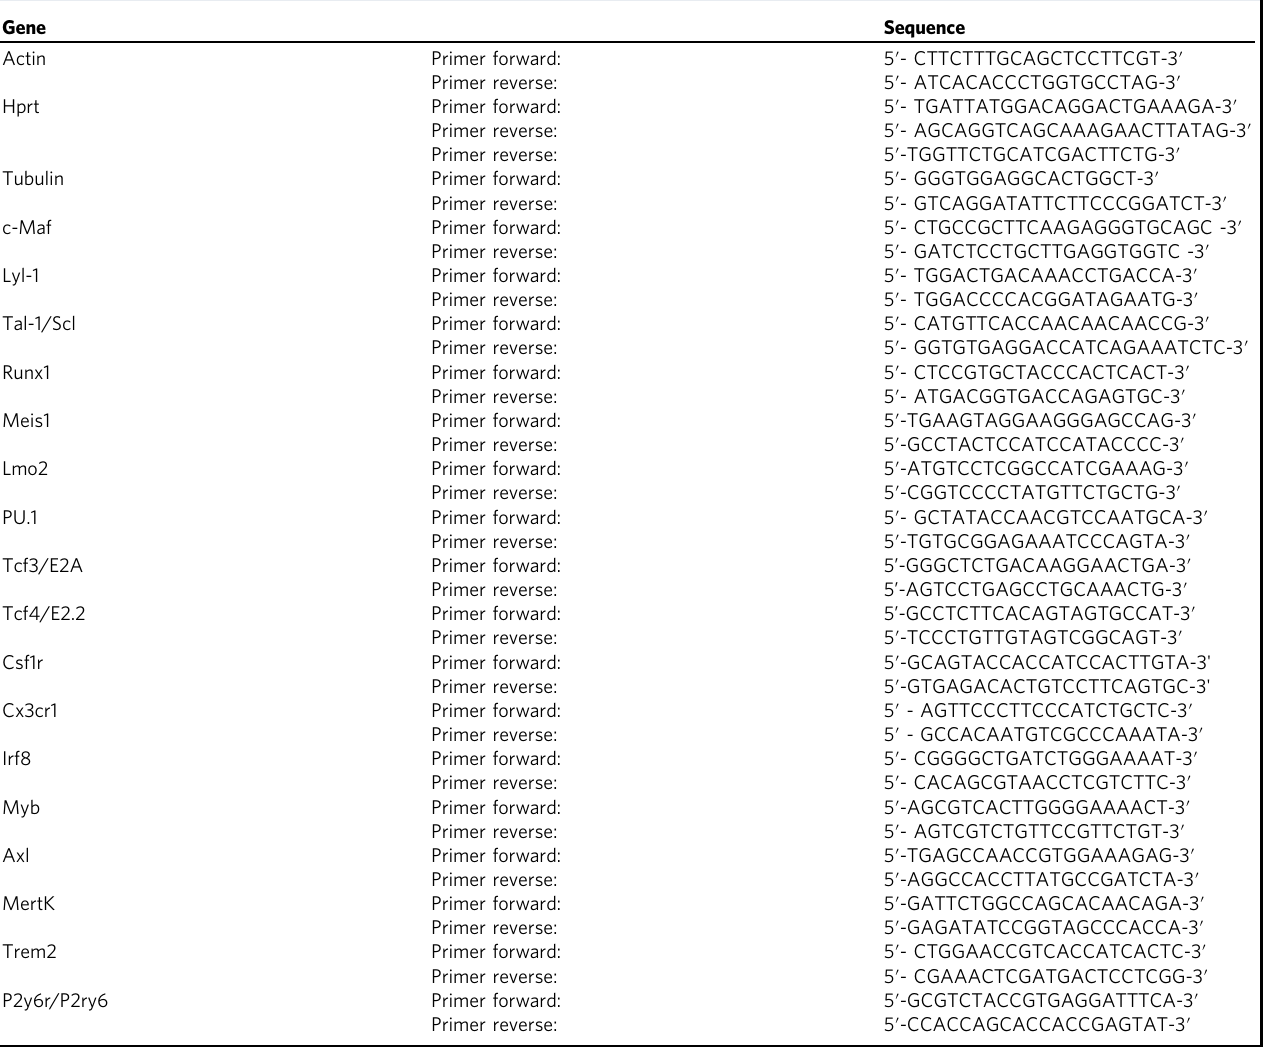
Table 4 Primers used in this